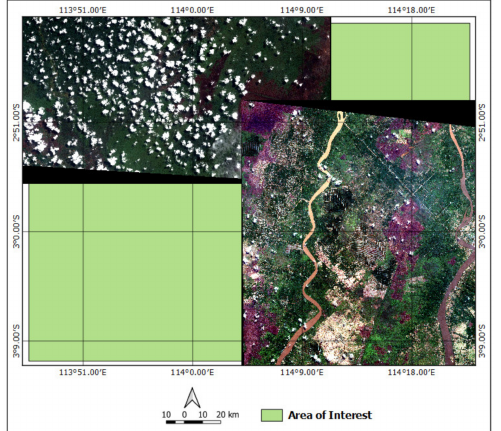
Figure 4. A coverage of SPOT data as the reference within the area of interest in Figure